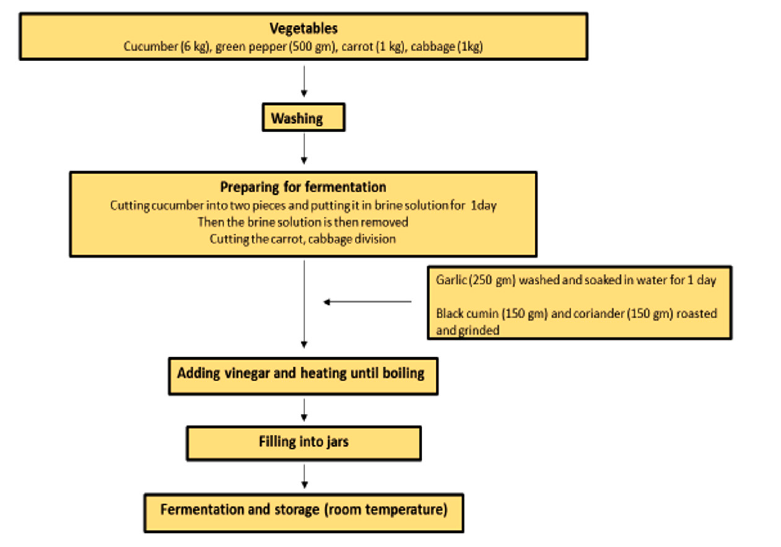
Fig. 1. Traditional Iraqi Turshi